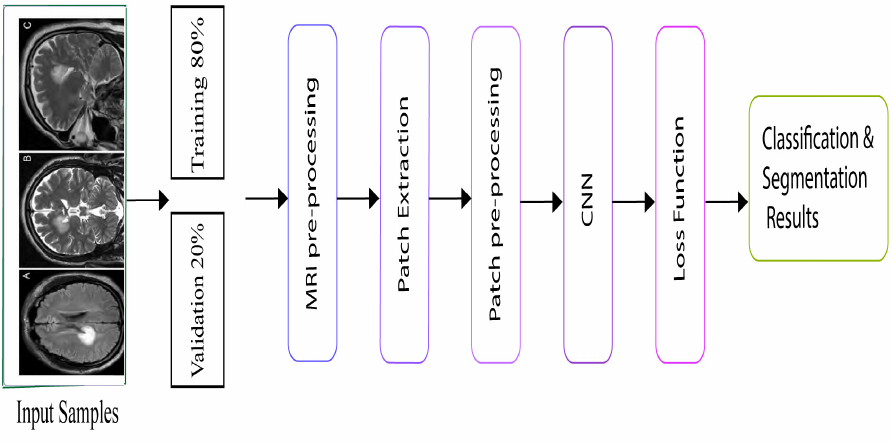
Figure 4. Proposed model flow